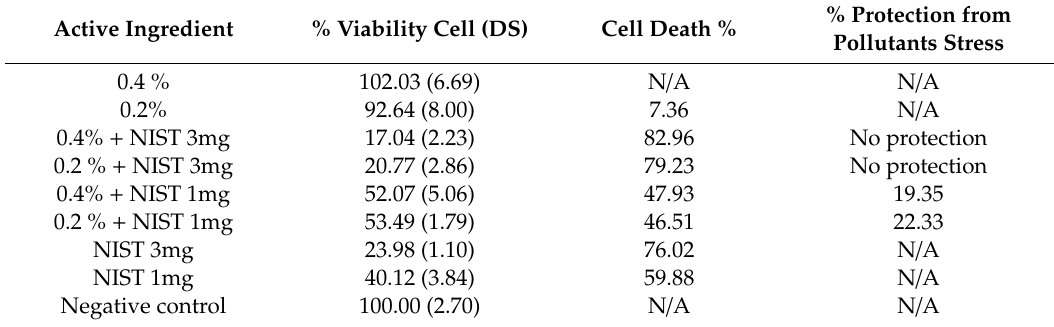
Table 5. Results: % protection from pollutants